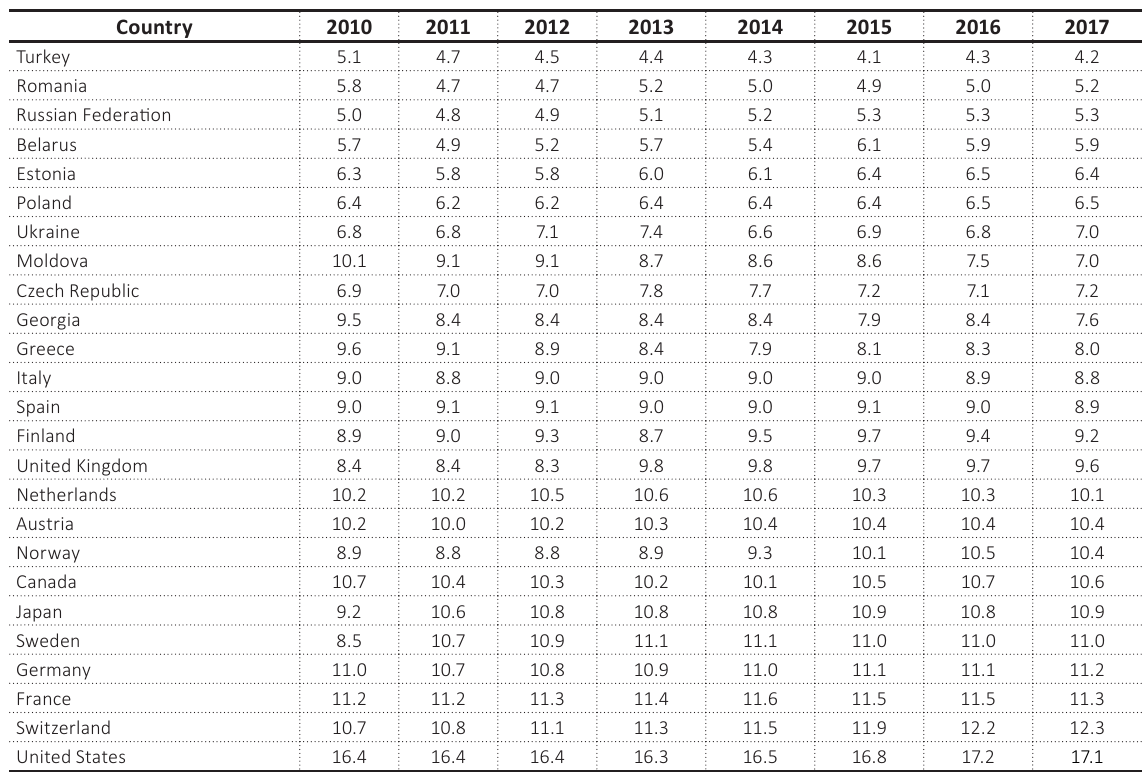
Table A1. Current health expenditure (% of GDP)